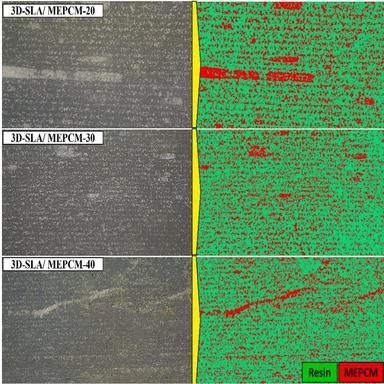
Display of the distribution of MEPCMs by segmenting optical microscope images with the Fiji program.